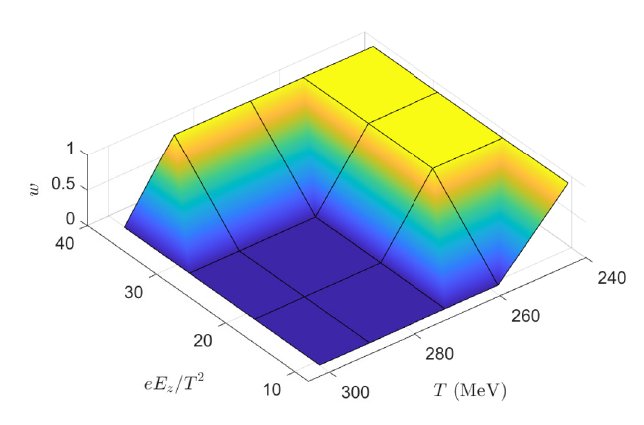
Figure 32 . w as a function of T and eE z /T 2 .